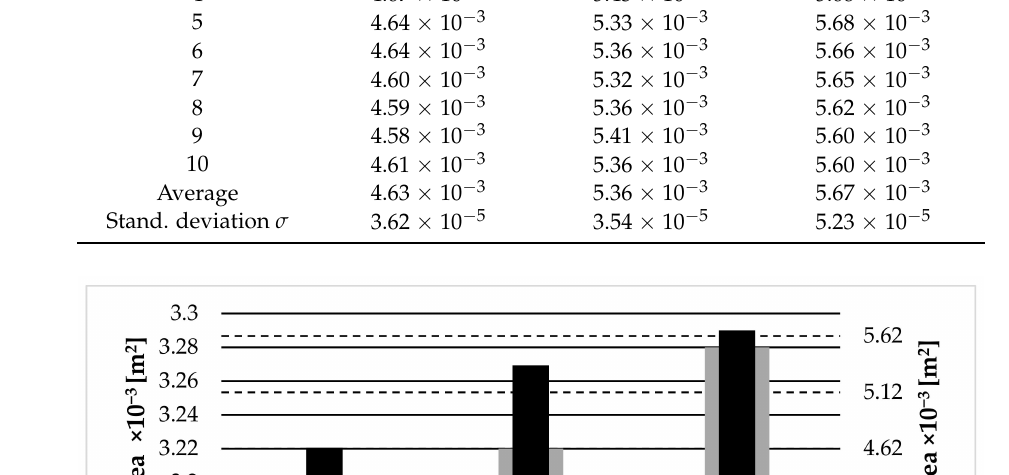
and S measurement_RSKCuIv4 = 3.18 × 10 − 3 ± 4.50 × 10 − 5 m 2 . The surface area of